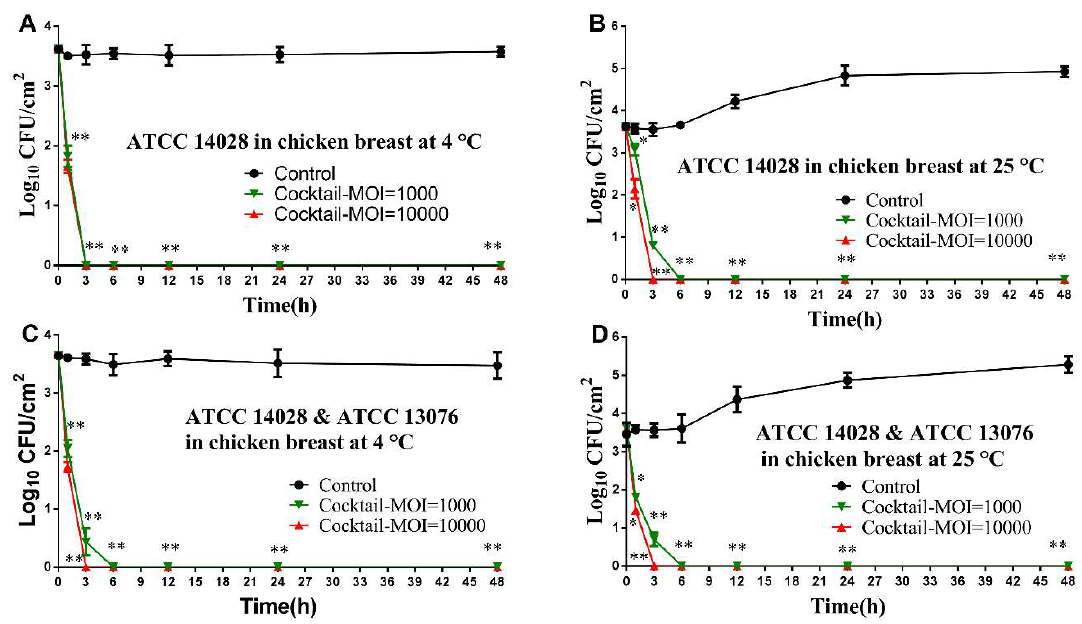
Figure 5. E ff ectiveness of phage cocktail in reducing the S. Typhimurium ATCC 14028 and S. Enteritidis ATCC 13076 in chicken breast. ( A ) E ff ect of phage cocktail on growth of S. Typhimurium ATCC 14028 in chicken breast at 4 ◦ C; ( B ) E ff ect of phage cocktail on growth of S. Typhimurium ATCC 14028 in chicken breast at 25 ◦ C; ( C ) E ff ect of phage cocktail on growth of Salmonella mixture ( S. Typhimurium ATCC 14028 and S. Enteritidis ATCC 13076) in chicken breast at 4 ◦ C; and E ff ect of phage cocktail on growth of Salmonella mixture ( S. Typhimurium ATCC 14028 and ( D ) S. Enteritidis ATCC 13076) in chicken breast at 25 ◦ C. Values represent mean with standard deviation of three